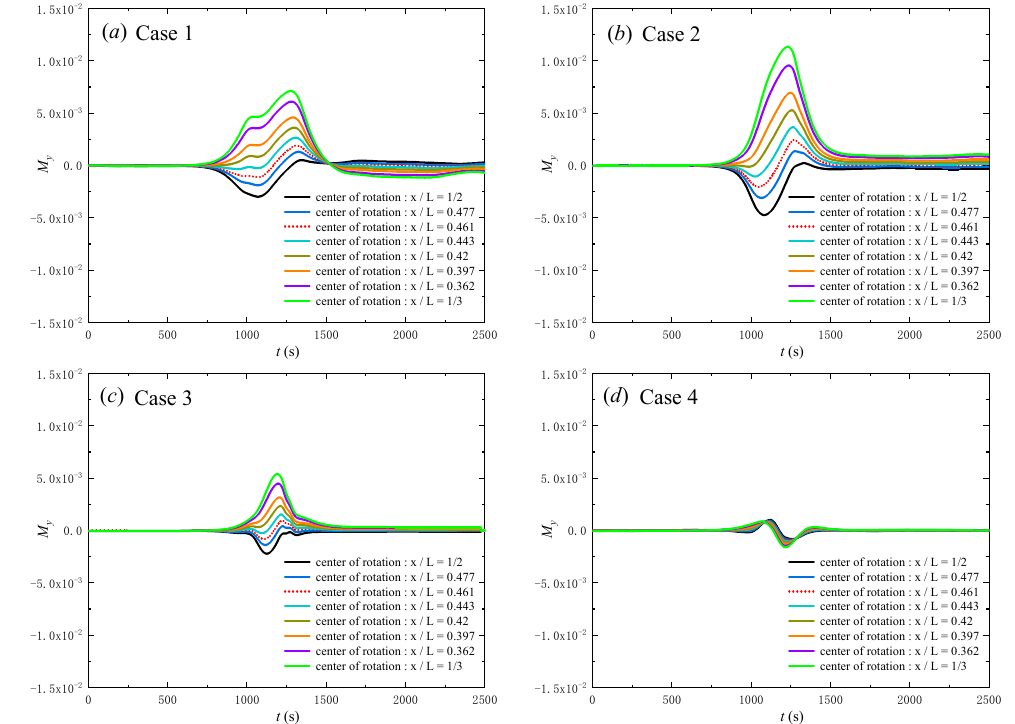
J. Mar. Sci. Eng. 2021 , 9 , x FOR PEER REVIEW Figure 19. Nondimensional moment of different rotation centre positions for SUBOFF-AFF-1. The nondimensional moments of different rotation centre positions for SUBOFF- AFF-8 under four conditions (Case 1, Case 2, Case 3 and Case 4) are shown in Figure 20. For each condition, only 16 curves among 30 simulated results are shown in the figure for clear vision. Figure 20 shows that in Case 1, Case 2 and Case 3, the maximum value of the positive nondimensional moment (clockwise rotation) appears at S = 1/3, and the maxi- mum value of the negative nondimensional moment (anticlockwise rotation) appears at S = 4/6. With the continuous increase in the position of the SUBOFF-AFF-8 rotation centre (1/3 to 2/3), the variation in the nondimensional moment is similar to that of SUBOFF- AFF-1. When the position of the rotation centre is the same, among the four cases, the magnitude of the nondimensional moment is the largest in Case 2 and smallest in Case 4, which is the same as SUBOFF-AFF-1. Comparing the nondimensional moments of SUB- OFF-AFF-1 and SUBOFF-AFF-8 (Figures 19 and 20) at the same value of S , for SUBOFF within the wave height range of the ISW, the nondimensional moment of SUBOFF-AFF-1 is slightly larger than that of SUBOFF-AFF-8; for SUBOFF lower than the trough bottom of the ISW, the nondimensional moment of SUBOFF-AFF-1 is slightly smaller than that of SUBOFF-AFF-8. To compare the difference between the nondimensional moments of SUBOFF-AFF-1 and SUBOFF-AFF-8 more clearly, the nondimensional moment at S = 0.466 is given (as shown in Figure 21). For SUBOFF-AFF-1 and SUBOFF-AFF-8 crossing the ISW, the nondimensional mo- ment is the largest, which is the most dangerous condition.